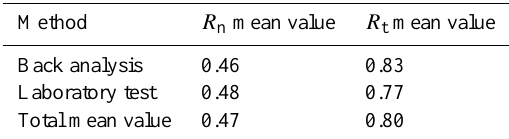
Fig. 9. Rockfall analysis at section C, in Fig. 11. Table 1. Rockfall parameters of limestone slope